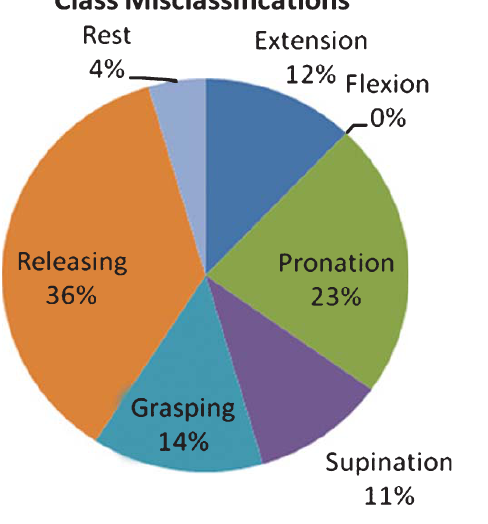
Fig. 8. Percentage of each individual class that was misclassified out of the total number of misclassifications for all subjects.